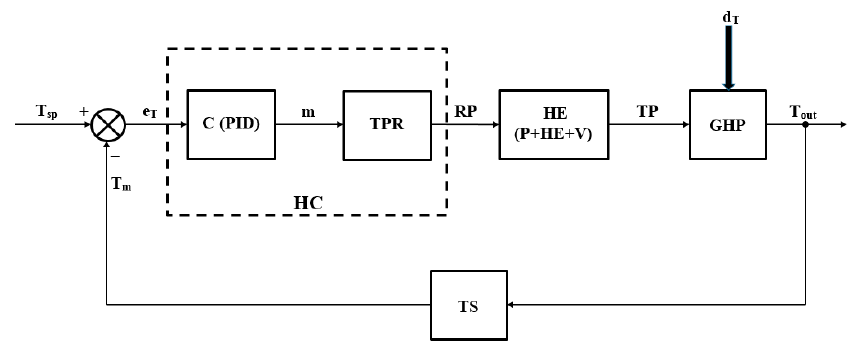
Figure 6. Control structure for the air temperature control inside the greenhouse (GHP, greenhouse heating process; HE, heating element; P, pump; V, ventilator; TS, temperature sensor; HC, hybrid controller; C (PID), PID-type controller; TPR, bi-positional (on/off) controller; T sp , temperature setpoint signal; T m , feedback signal (measured temperature); e T , temperature error signal; m, modulation index; RP, rectangle pulse (control signal); TP, thermal power; T out , output temperature (controlled signal, air temperature inside the greenhouse); d T , equivalent disturbance signal that directly modifies the T out value (e.g., the external temperature or solar radiation)).